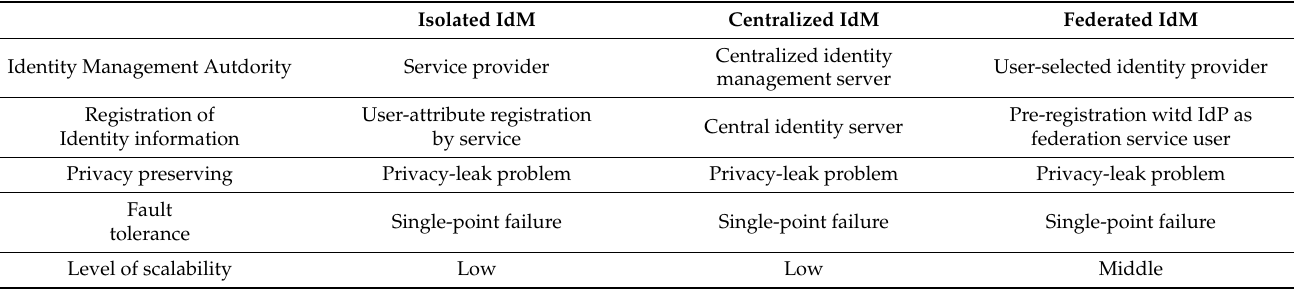
Table 1. Characteristics of IdM.